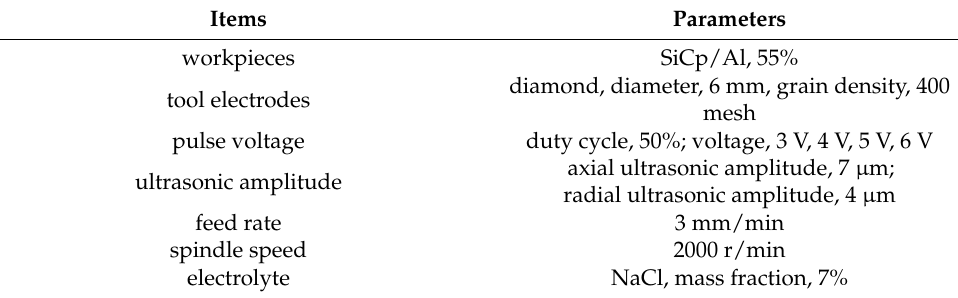
Table 4. Different pulse voltage machining parameters.